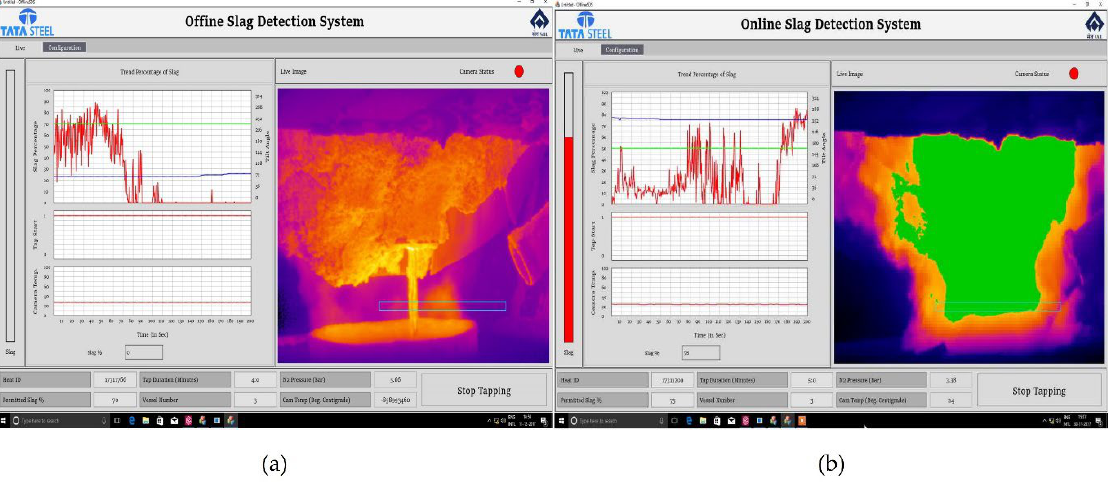
Figure 9. ( a ) LWIR image of the tapping stream while steel is pouring out of the furnace. The tem- perature of the stream was about 1650 °C. ( b ) Under flames and fumes condition, the images cap- tured by the LWIR camera can be quite noisy, and any measurement made on these data will be useless [57].